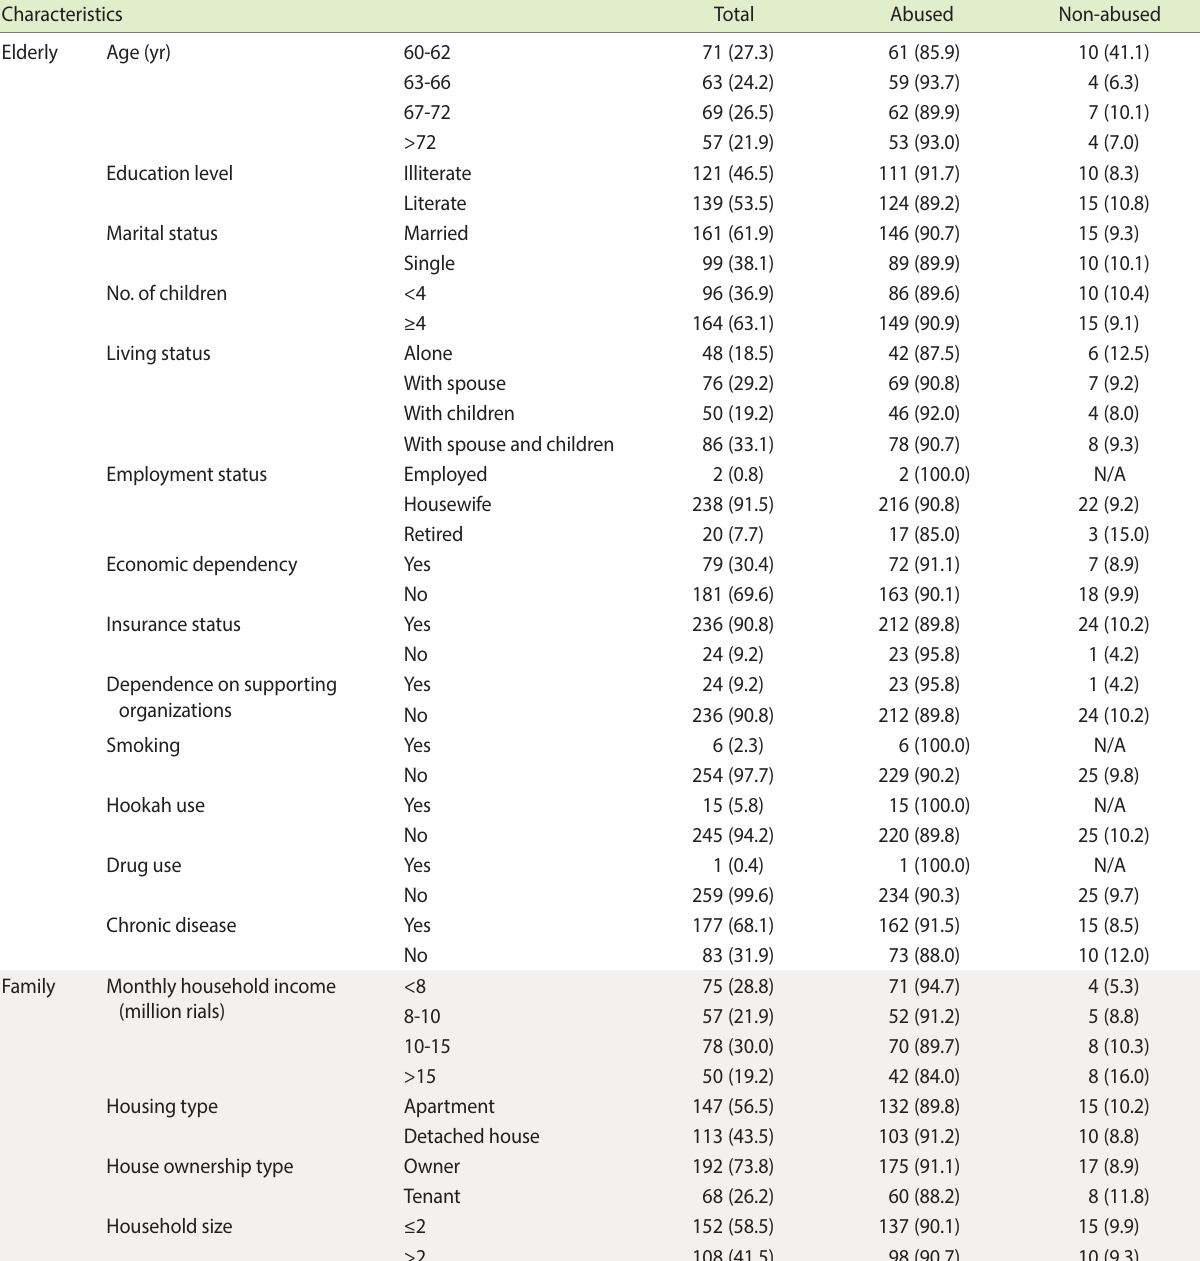
Table 1. General characteristics of the subjects studied